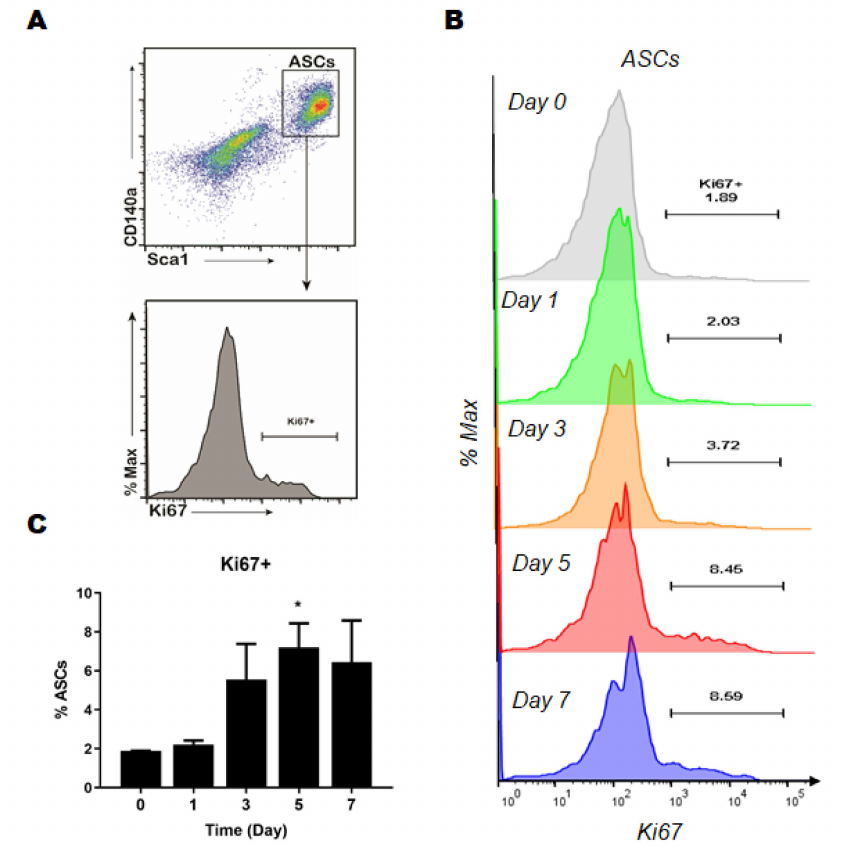
Figure 2. Quantitative analysis of adipocyte-derived stem cells (ASCs) proliferation; ( A ) Gating strategy for flow cytometry analysis; ( B ) Representative flow cytometry profiles showing proliferating (Ki-67 + ) ASCs at day 0 (gray), 1 (green), 3 (orange), 5 (red) and 7 (blue); ( C ) Quantitation of proliferating ASCs (Ki67 + ) in adipose tissue at different time points. Data are means ± SEM ( n = 4). * p < 0.05 versus day